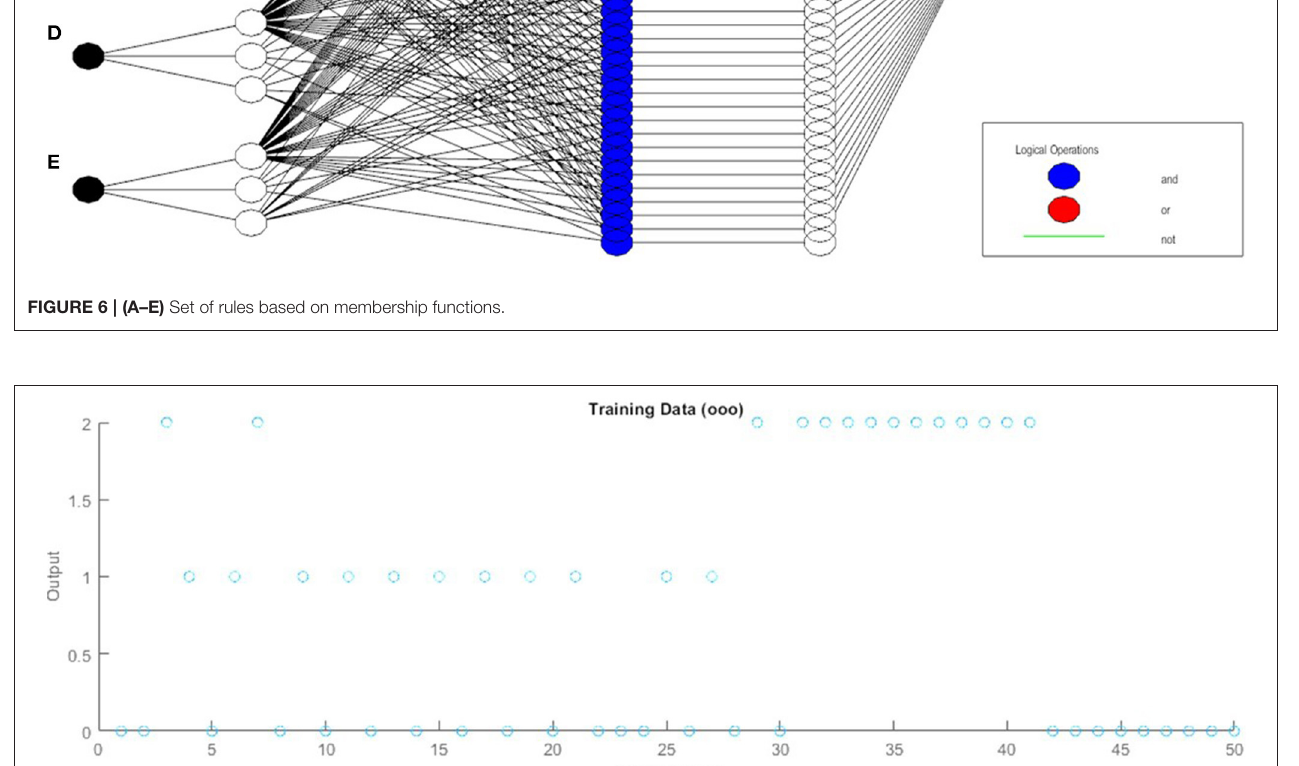
FIGURE 7 | Proposed ANFIS model.